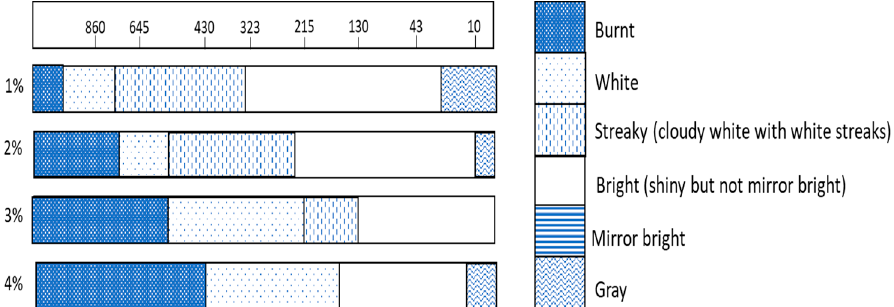
Figure 1. Hull cell deposit appearance produced from 1%, 2%, 3%, and 4% additive concentrations. Bath composition was 37.5 g L − 1 zinc and 210 g L − 1 NaOH held at 40 °C. A Hull cell ruler is presented at the top with current densities in A m − 2 .